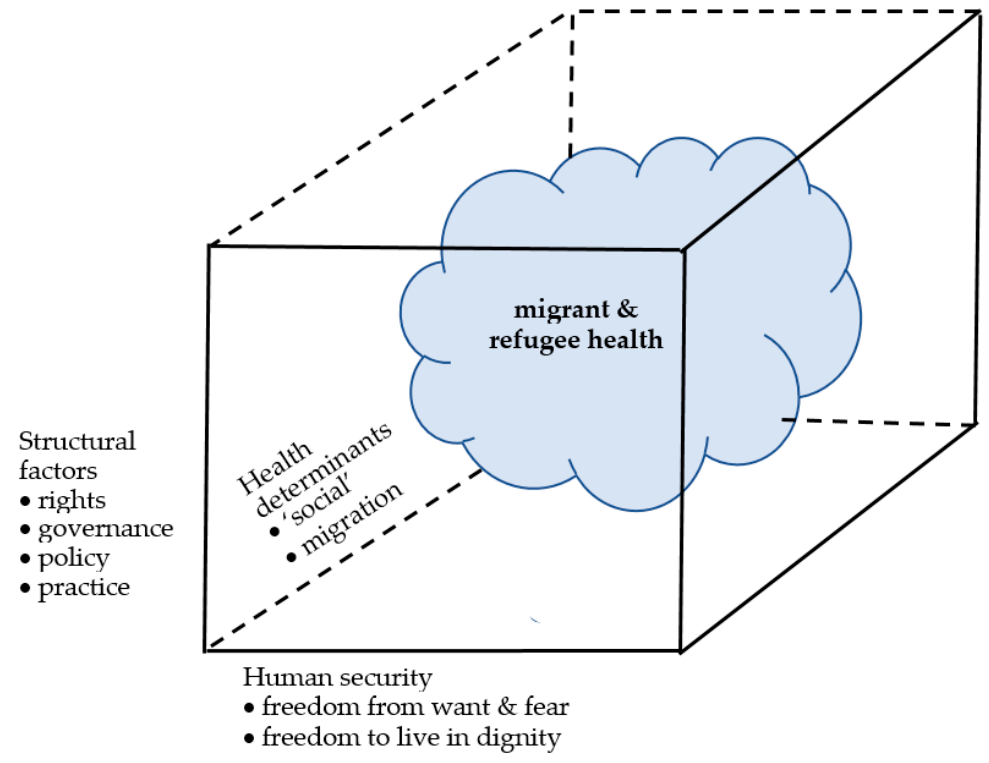
Figure 1. Perspectives contributing to migrant and refugee health in the COVID-19 pandemic.